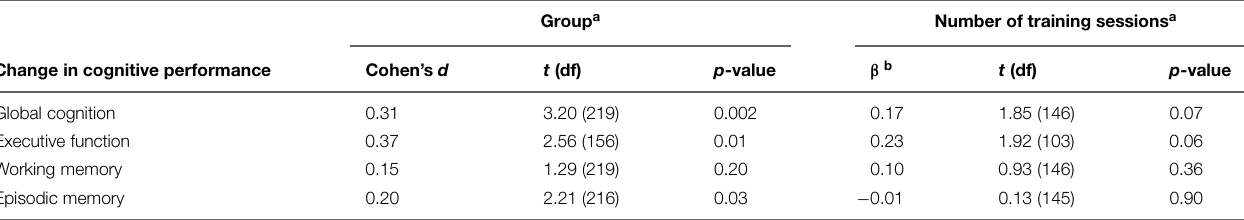
TABLE 2 | Effects of intervention group and dosage on change in